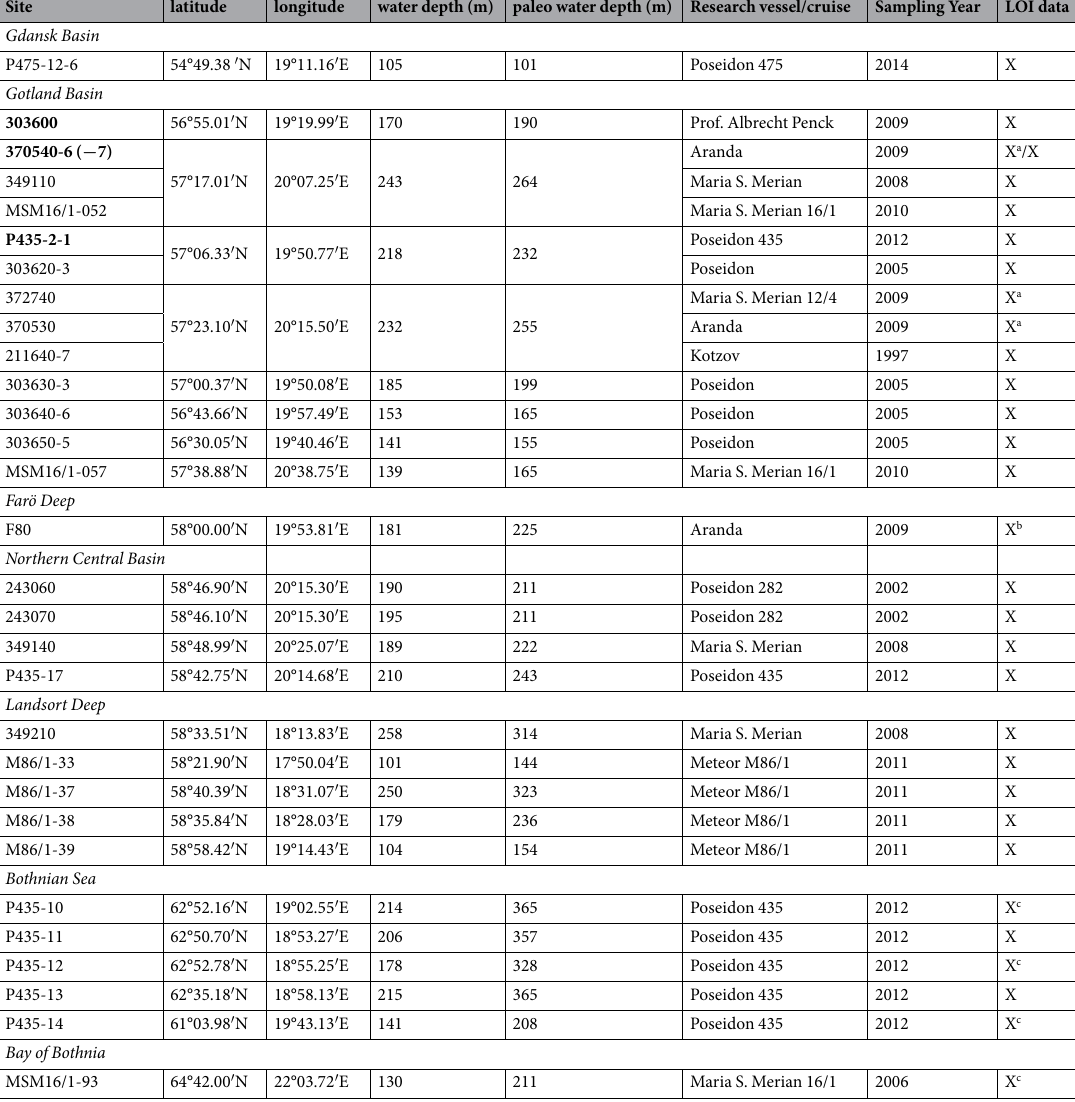
Table 1. Details on the core sites studied located in almost all basins of the Baltic Sea. The location (see Figure S1 for a map), present-day and estimated paleo-water depths (6,500 cal. yr BP) are indicated, along with cruises and years of sampling of sites. Key-sites for chronology and proxy studies are marked in bold font. Loss on ignition (LOI) data are available from all sites. LOI data from cores marked with (X) are shown in Figs S2–S4. a LOI record previously published 36 ; b LOI record previously published 49 , c LOI record previously published 50